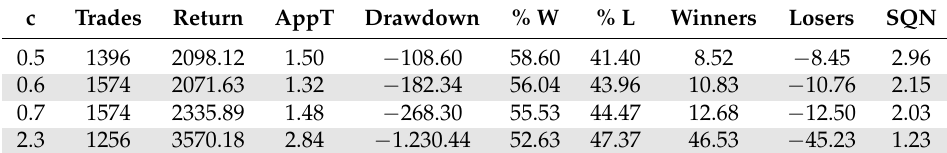
Table 11. Columns Return , APpT , % W , % L , Winners , Losers , SQN are calculated as a weighted average of the corresponding values shown in Table 10, being the column Trades the weights employed.